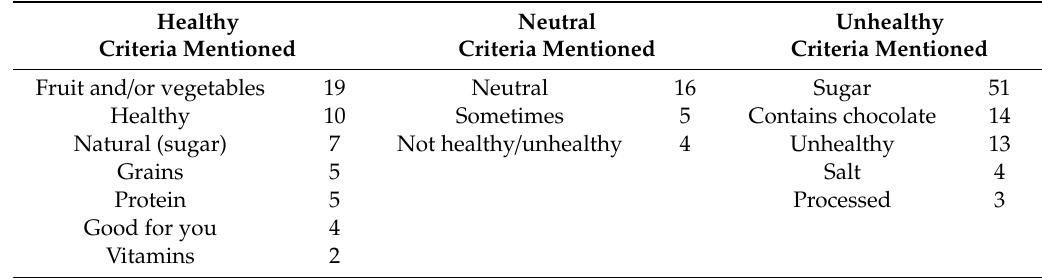
Table 5. Frequency of reasons given for sorting a food / beverage by the child participants ( n =